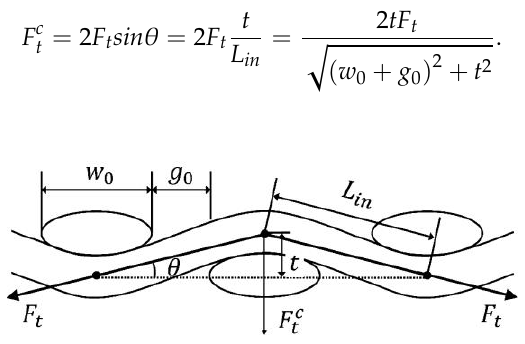
Figure 4. Dissipation energy of friction.